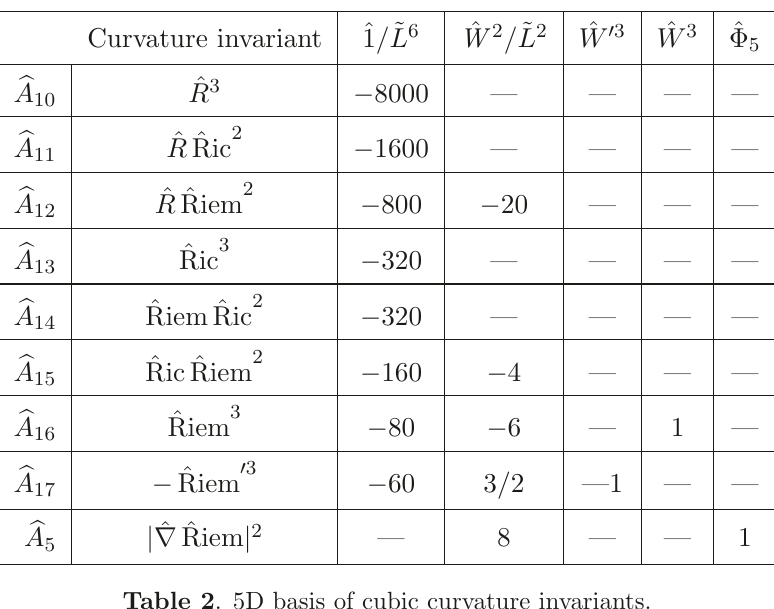
Table 2 . 5D basis of cubic curvature